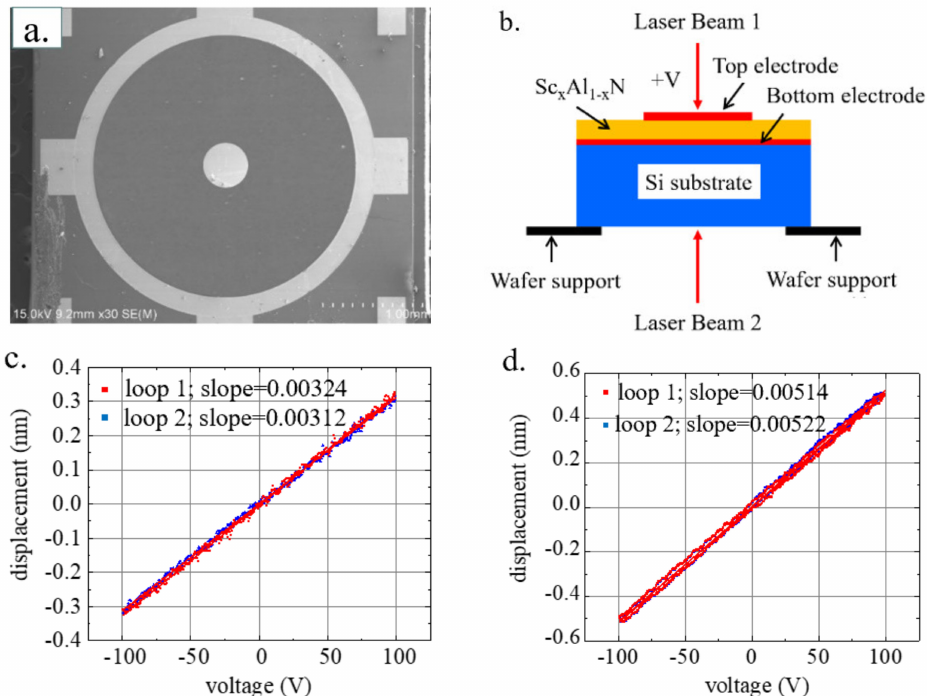
Figure 3. ( a ) The scanning electron microscope (SEM) image of the device used in DBLI test. ( b ) Schematic diagram of DBLI test system and test principle; ( c ) DBLI test results of AlN and ( d ) AlScN.